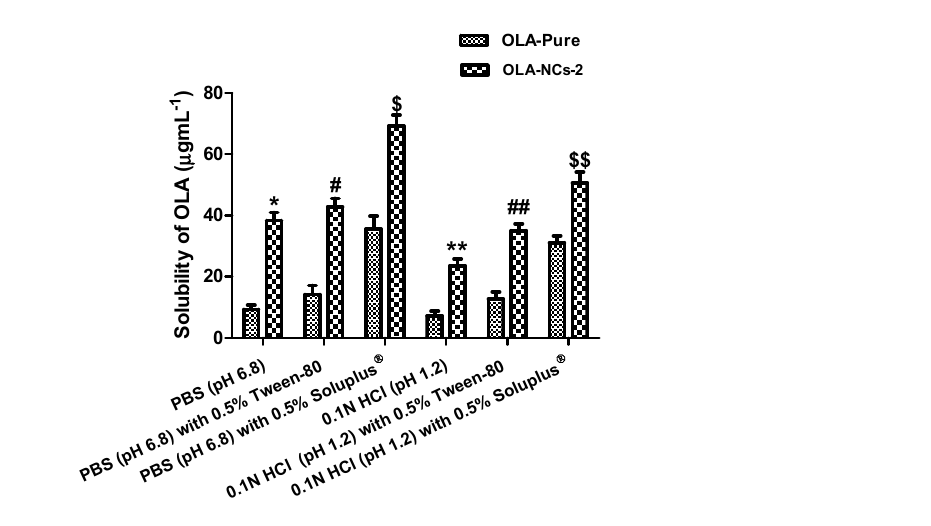
Figure 6. Solubility of Olaparib (OLA) in different solvents. All the data are expressed as mean of three measurements with standard deviation (Mean ± SD, n = 3) * p < 0.05 OLA-NCs-2 vs. OLA-pure in PBS; # p < 0.05 OLA-NCs-2 vs. OLA-pure in PBS with 0.5% Tween-80 and $ p < 0.05 OLA-NCs-2 vs. OLA-pure in PBS with 0.5% Soluplus ® . ** p < 0.05 OLA-NCs-2 vs. OLA-pure in 0.1N HCl (pH 1.2); ## p < 0.05 OLA-NCs-2 vs. OLA-pure in 0.1N HCl (pH 1.2) with 0.5% Tween-80 and $$ p < 0.05 OLA-NCs-2 vs. OLA-pure in 0.1N HCl (pH 1.2) with 0.5% Soluplus ® .